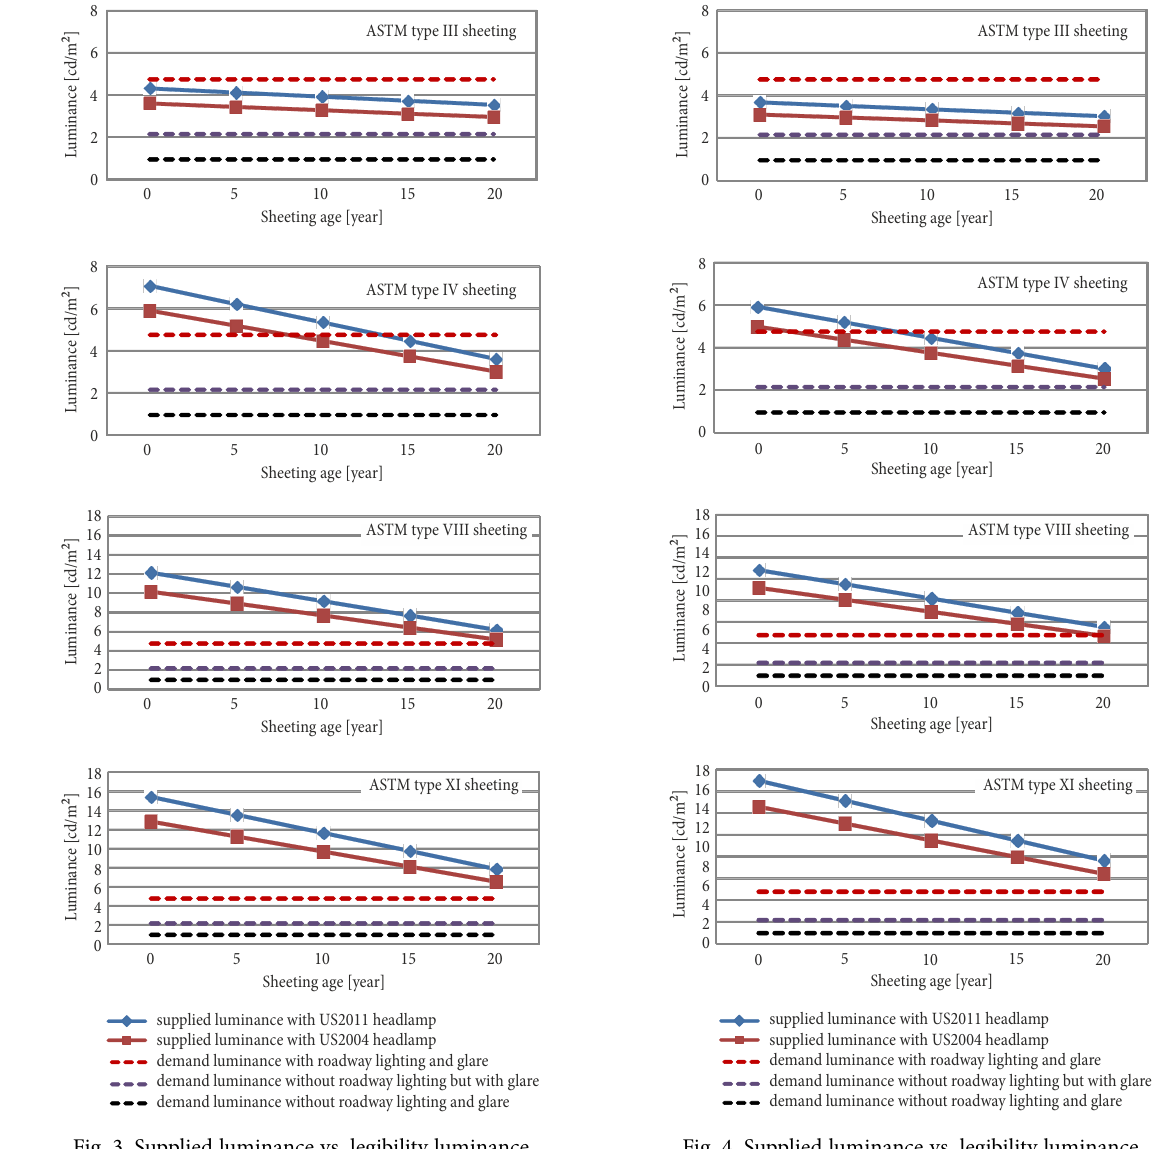
Fig. 3. Supplied luminance vs. legibility luminance for passenger cars